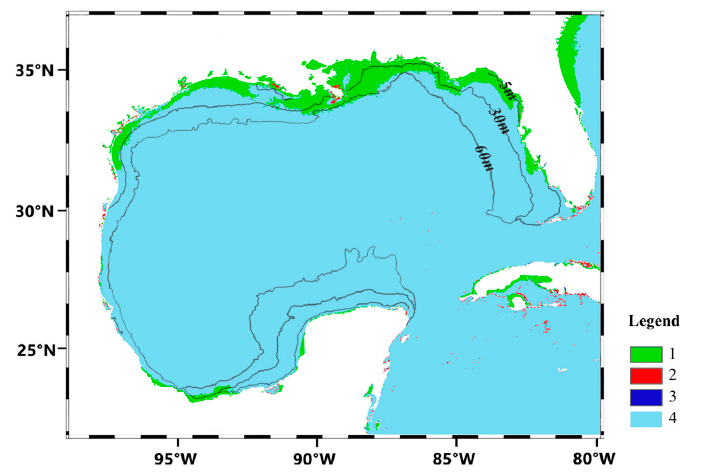
Figure 6. Partitioning according to the model rules; the water depth marked on the figure. On the whole, region 1 was mainly distributed in the nearshore aera, while region 2 and region 3 were scattered in estuaries and nearshore places with water depths less than 5 m. Region 4 occupied the largest area of GOM, covering a large area of open sea. In general, this distribution of the sub-regions corresponded to water depth, the area with depth of less than 30 m comprised most of region 1. The other areas of region 1, such as a small area on the south side of the GOM and west side of Yucatan, were consistent with the distribution of water bodies, which has great influence on the zoning and was also reflected in the distribution of region 2. Most areas of region 2 mainly correspond to the estuary area, where the river water is mixed with seawater, and the salinity was different from that of region 1. Region 4 covered most of the GOM area—mainly open sea areas. Referring to the division rules, we can see that the temperature in region 2 was higher than that in region 4. This may be because a larger amount of data was distributed in summer, and high temperature can also be used to explain that other areas in region 2 are mainly in the Loop Current range, corresponding to warm Florida currents. Region 3 cor- responds to very few areas, which may be due to the small number of samples in rule 3. 4.2. Seasonal Variations of Surface Salinity The salinity of the GOM presents a gradient distribution throughout the year, with low values in the nearshore and high values in open seas. The areas near fresh water vary greatly, and sea water with high temperature and high salinity brought by the Loop Cur- rent can also be observed (Figure 7).